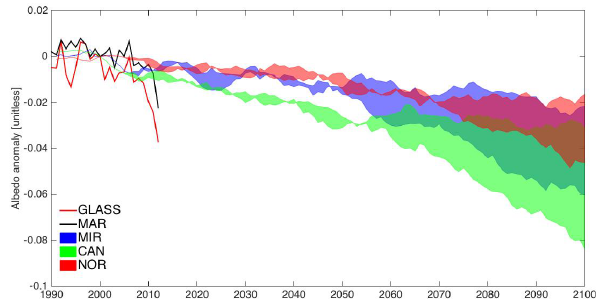
Figure 11. Projections of broadband albedo anomaly (with re- spect to the year 2000) averaged over the whole GrIS for 1990– 2012 from MAR simulations and GLASS retrievals (black and red lines, respectively), and as projected by 2100. Future projections are simulated with MAR forced at its boundaries with the out- puts of three ESMs under two warming scenarios, with the first scenario (RCP45) corresponding to an increase in the atmospheric greenhouse gas concentration to a level of 850ppm CO 2 equivalent by 2100 and the second (RCP85) to > 1370pm CO 2 equivalent. The top and the bottom of the coloured area plots represent the results concerning the RCP45 (top panels) and RCP85 (bottom panels) sce- narios. Semi-transparent colours are used to allow overlapping data to be viewed. Dark green corresponds to the case where MIROC5 and CANESM2 results overlap and brown to the case when the re- sults from the three ESMs